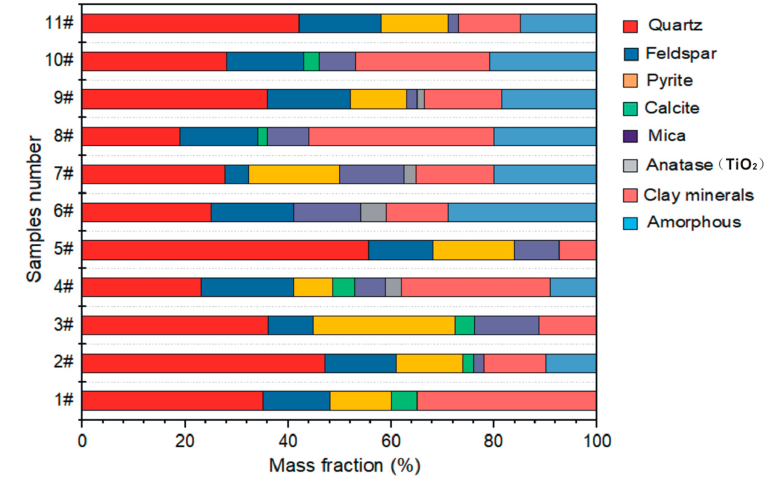
Figure 4. The percentage content of minerals from outcrop shales.